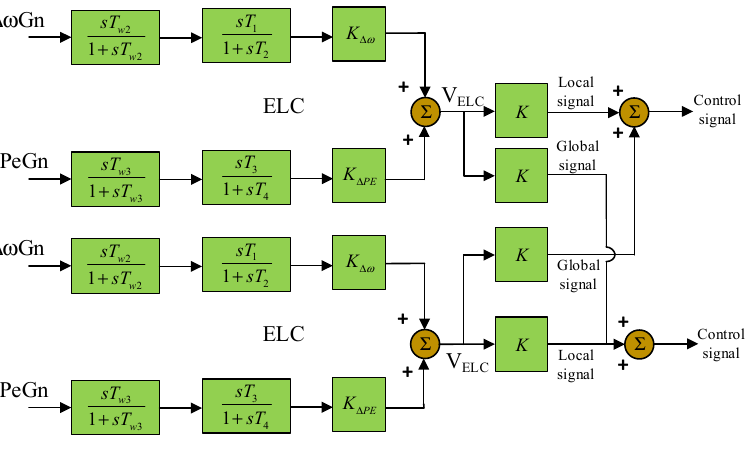
Figure 3. Multimodal control